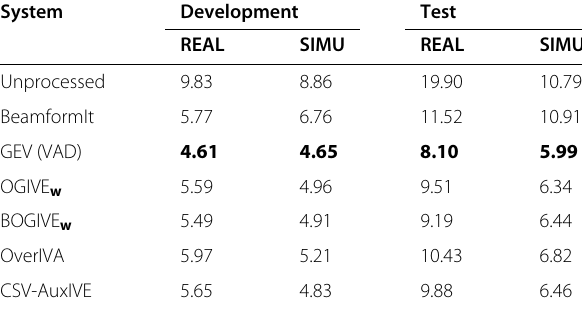
noted that the rates achieved by the BSE techniques are comparable to GEV even without a training stage on any CHiME-4